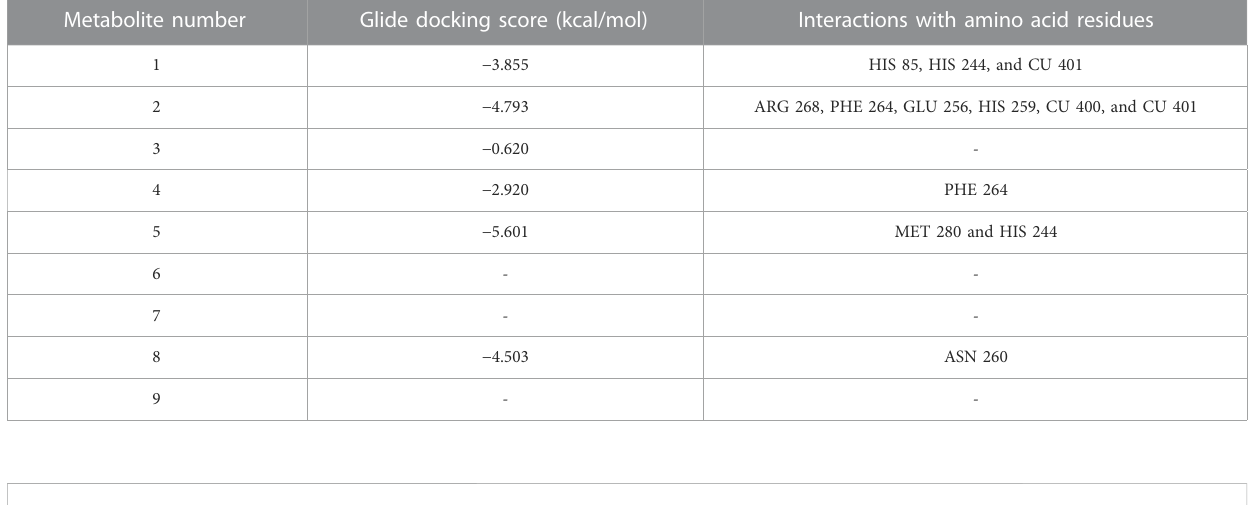
TABLE 2 Glide docking scores and amino acid interactions of identi fi ed metabolites with the tyrosinase crystal structure.